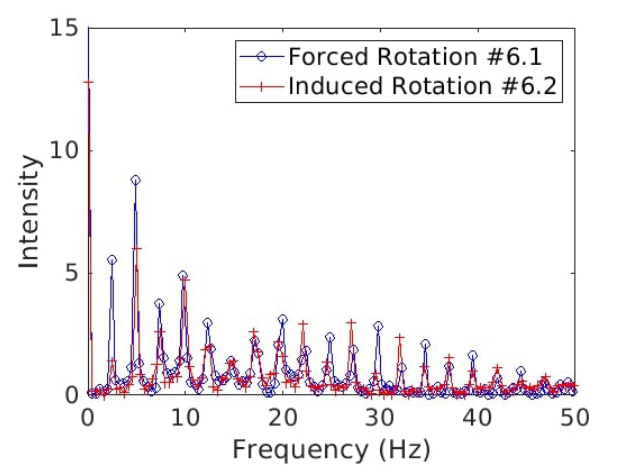
Figure 33. Frequency-based spectra of the vorticity for forced (blue line, #6.1) and induced (red line, #6.2) rotation cases.